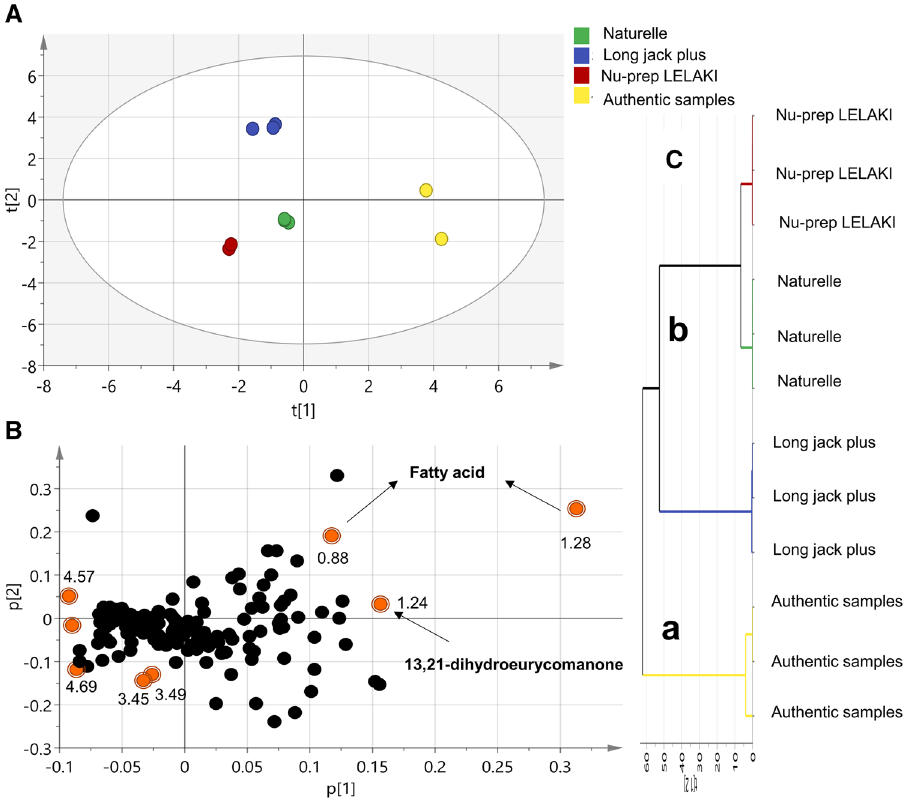
Figure 2. Principal component analysis (PCA) and hierarchical cluster analysis (HCA) of E. longifolia commercial preparations NMR dataset. ( A) Score plot of PC1 vs . PC2, complete segregation of the authentic samples from the commercial products. ( B) Loading plot for PC1 and PC2 showing signals of fatty acids ( δ 0.88, 1.28 ppm) and 13,21-dihydroeurycomanone ( δ 1.24 ppm) as the major signals contributing to samples discrimination. ( C ) HCA of NMR dataset shows two main cluster: cluster (a) for the authentic samples and cluster (b) for the commercial product